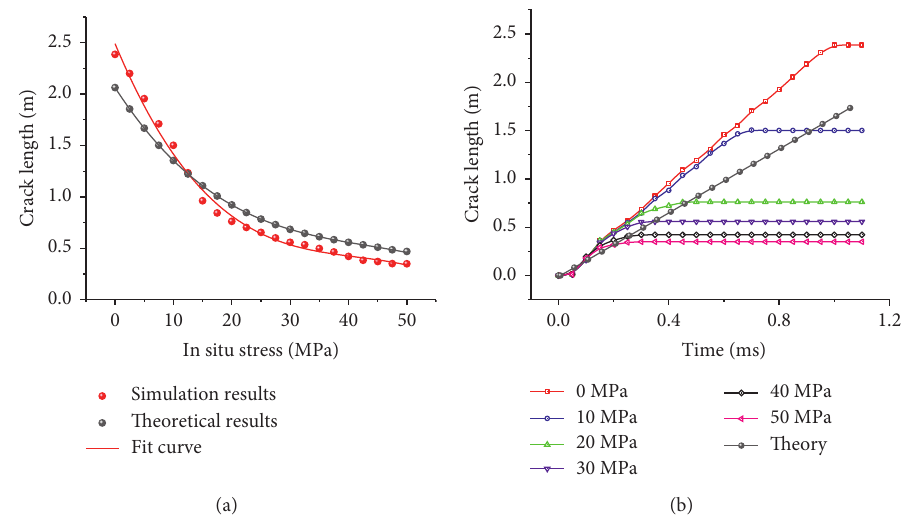
Figure 9: Crack lengths (a) with various in situ stresses (b) at different times ( K